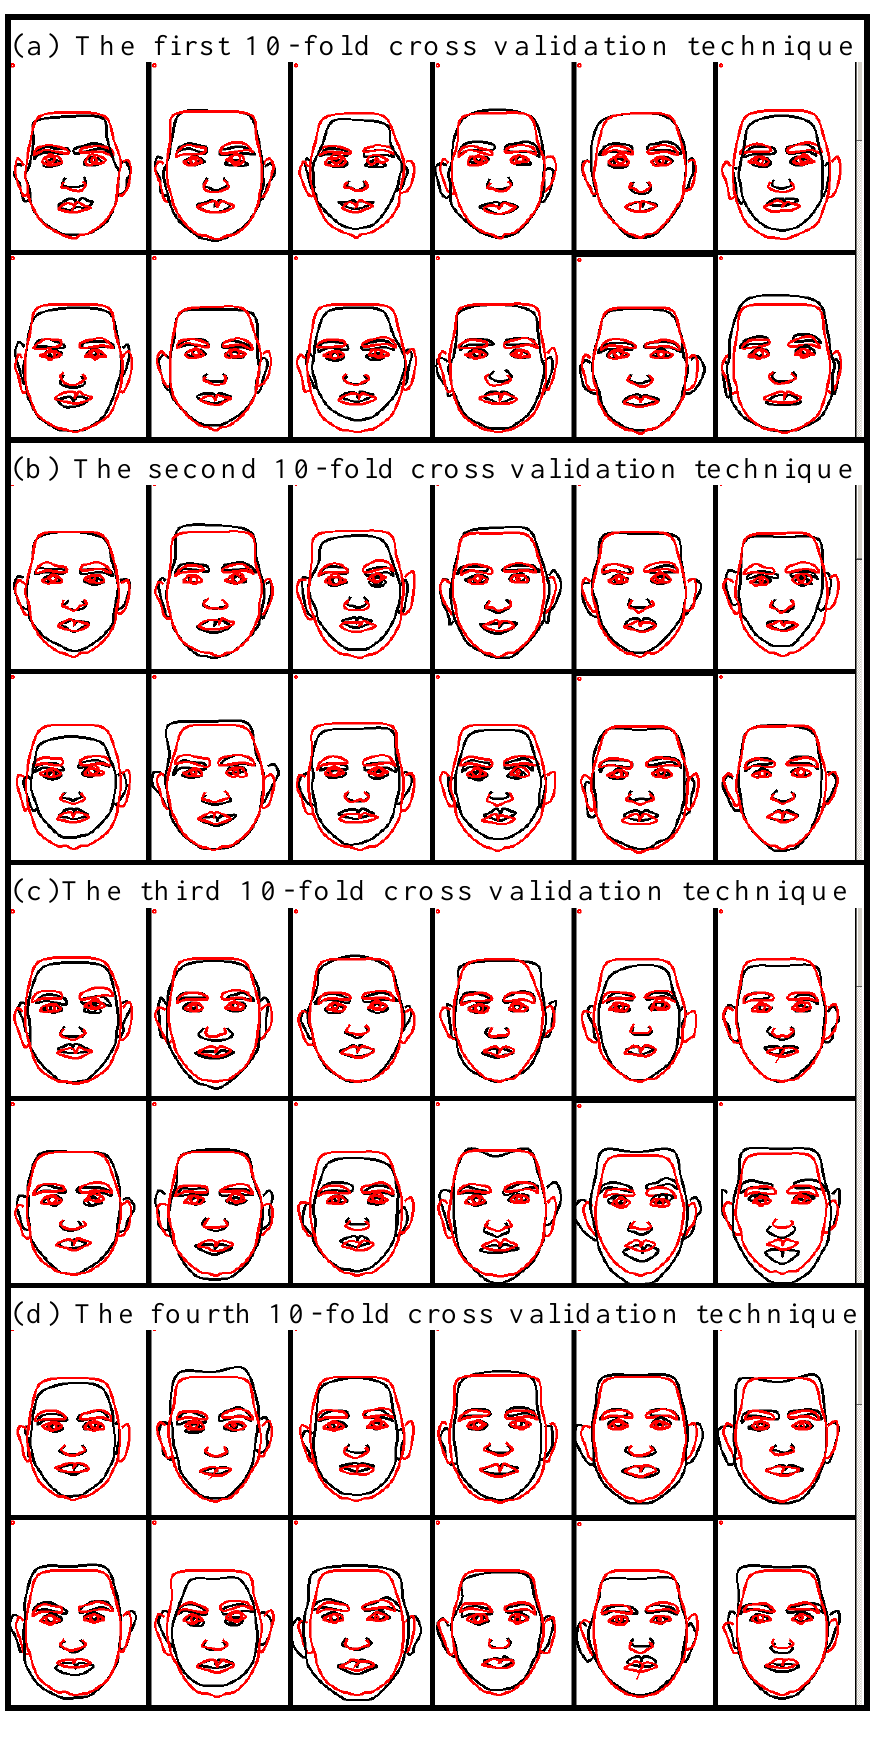
Figure 16. Results for 10 different test data